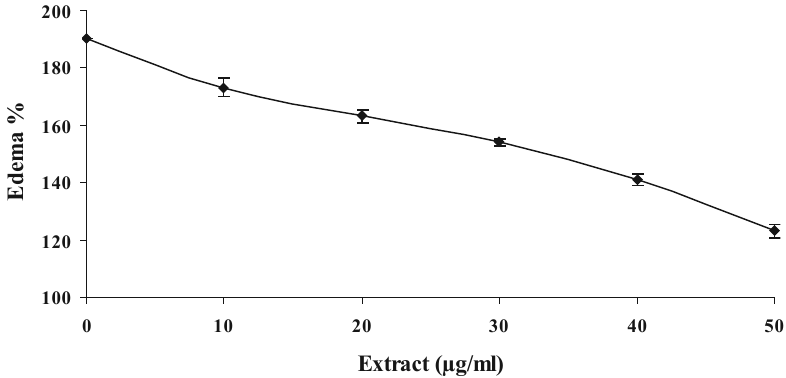
Figure 5 - Effect of calcium concentration on inhibition of NN-XIa-PLA by 2 aqueous stem bark extract of M. indica . The reaction mixture contained NN-XIa- PLA enzyme in 0.05 M Tri-HCl buffer pH 7.5, and 0–15mM CaCl in fi nal volume. 2 2 The reaction was initiated by adding substrate. The reaction was carried out in the absence (rhombus) and presence of IC concentration of extract (open square) with 50 increasing concentration of calcium. The fi gure inset represents percentage inhibition in the presence of the IC concentration. Data represents ± S.E.M for 50